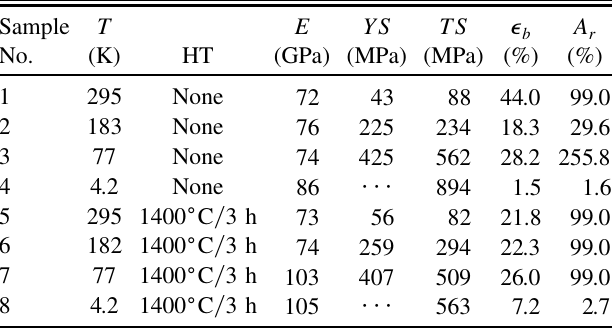
TABLE II. Results from tensile tests ( T : temperature; E : Young’s modulus; YS : yield strength at 0.2% strain; TS : tensile strength; (cid:5) b : elongation at fracture; A r : area reduction) con- ducted at different temperatures on non-heat-treated samples and samples heat treated at 1400 (cid:1) C for 3 h.